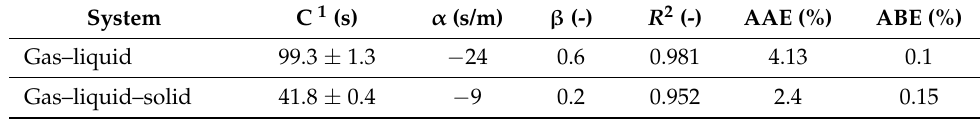
Table 13. Homogenization time t H : Evaluated parameters of correlation